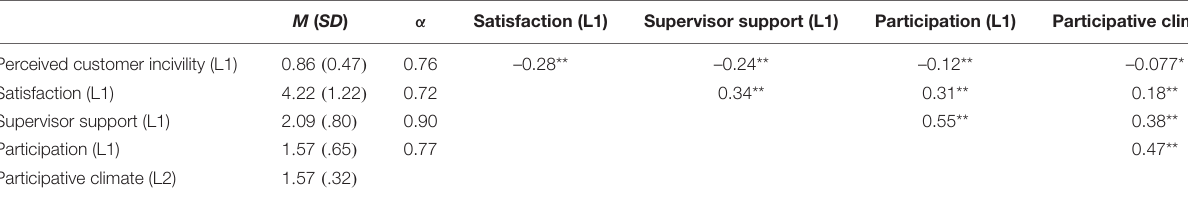
TABLE 1 | Correlations, reliabilities, and descriptive statistics for key study variables.